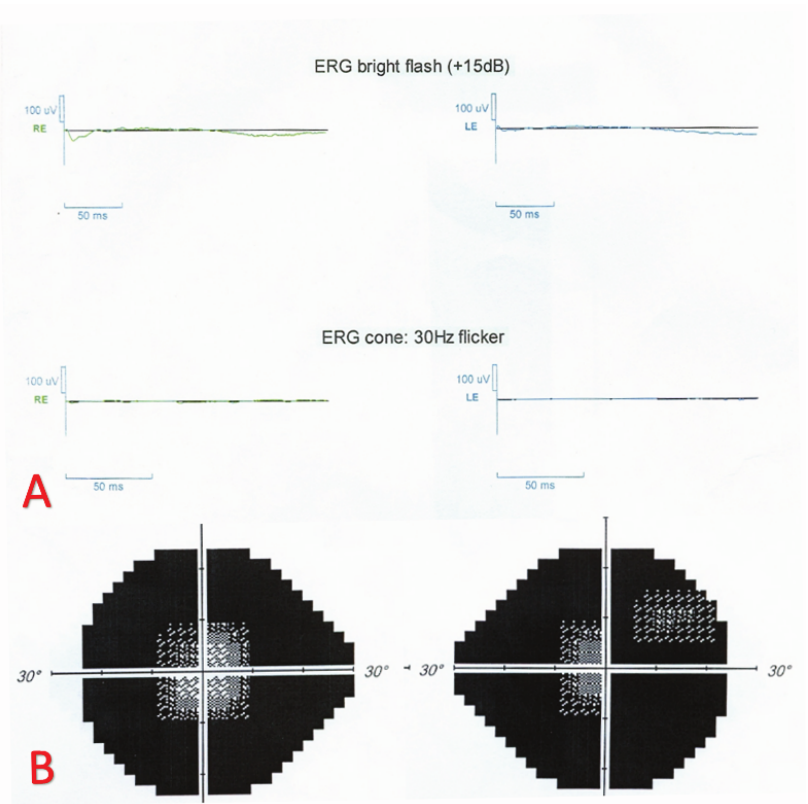
Figure 4. (A) Both photopic and scotopic responses are severely extinguished on full-field electroretinography. (B) The 24-2 Humphrey visual field depicts severe field constriction with foveal